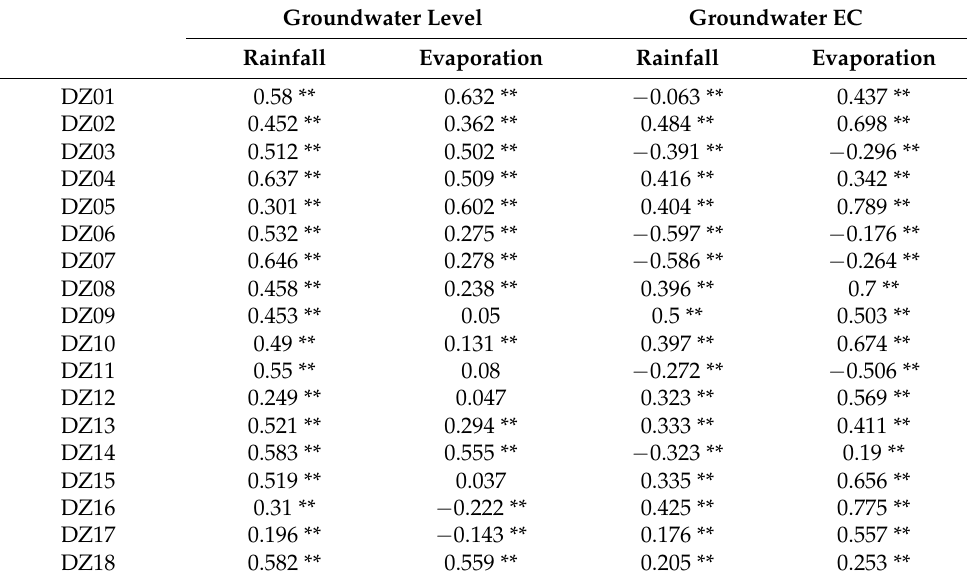
Table 3. The correlation analysis results between the seasonal components of groundwater level and EC with the seasonal components of rainfall and